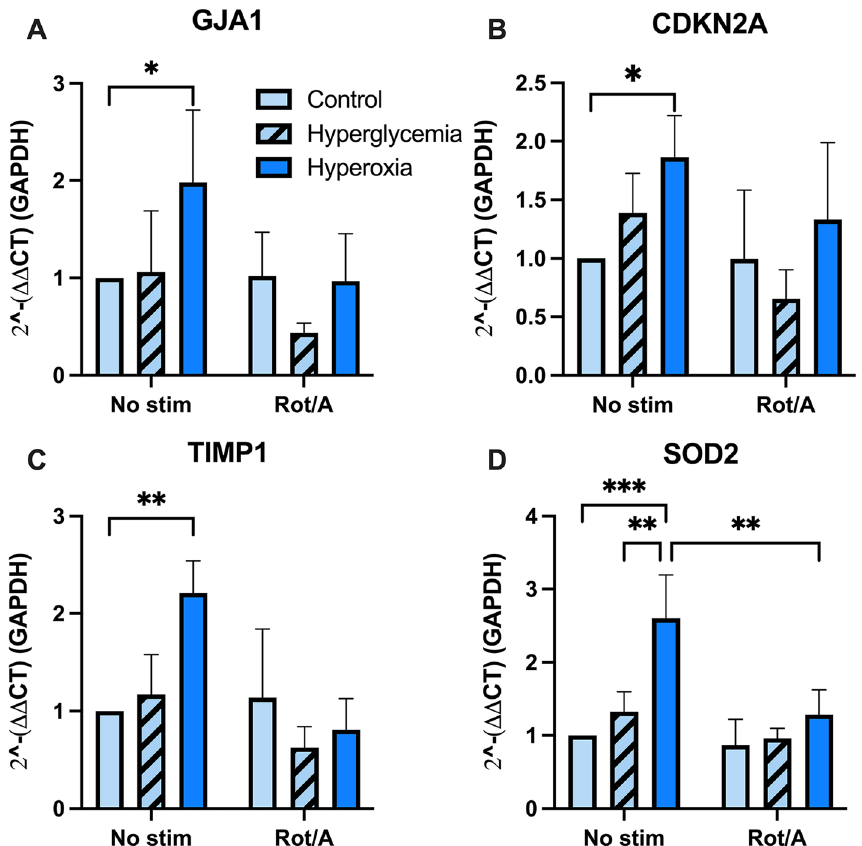
Figure 4. Chondrocyte gene expression changes in hyperoxia and with rotenone/antimycin inhibition. ( A ) Gap junction protein alpha 1 (GJA1) expression increased in non-stimulated chondrocytes cultured in hyperoxia, n = 4. ( B ) Cycling dependent kinase inhibitor 2A (CDKN2A) expression increased in hyperoxia, n = 4. ( C ) Tissue metallopeptidase inhibitor 1 (TIMP1) expression increased in non-stimulated chondrocytes cultured in hyperoxia, n = 4. ( D ) Superoxide dismutase 2 (SOD2) expression increased in chondrocytes cultured in hyperoxia, n =